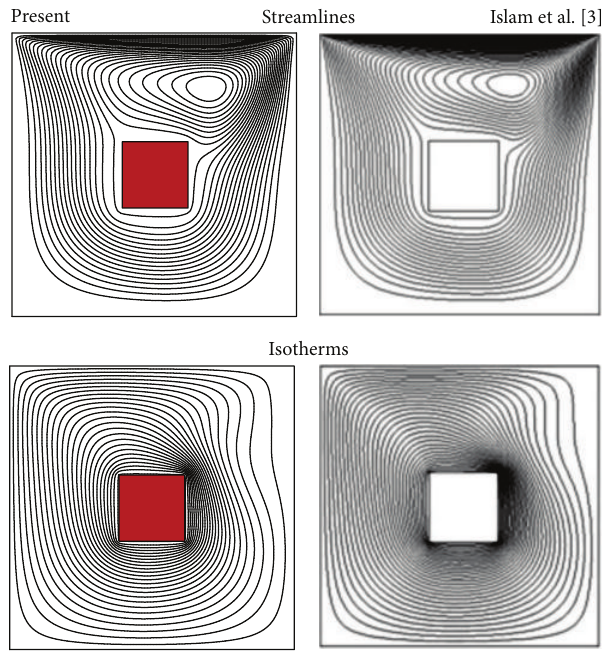
Figure 2: Comparison of the streamlines and isotherms between the present results and that of Islam et al. [3] (ℎ/𝐻 = 0.25, Re = 100, and Ri = 0.1)